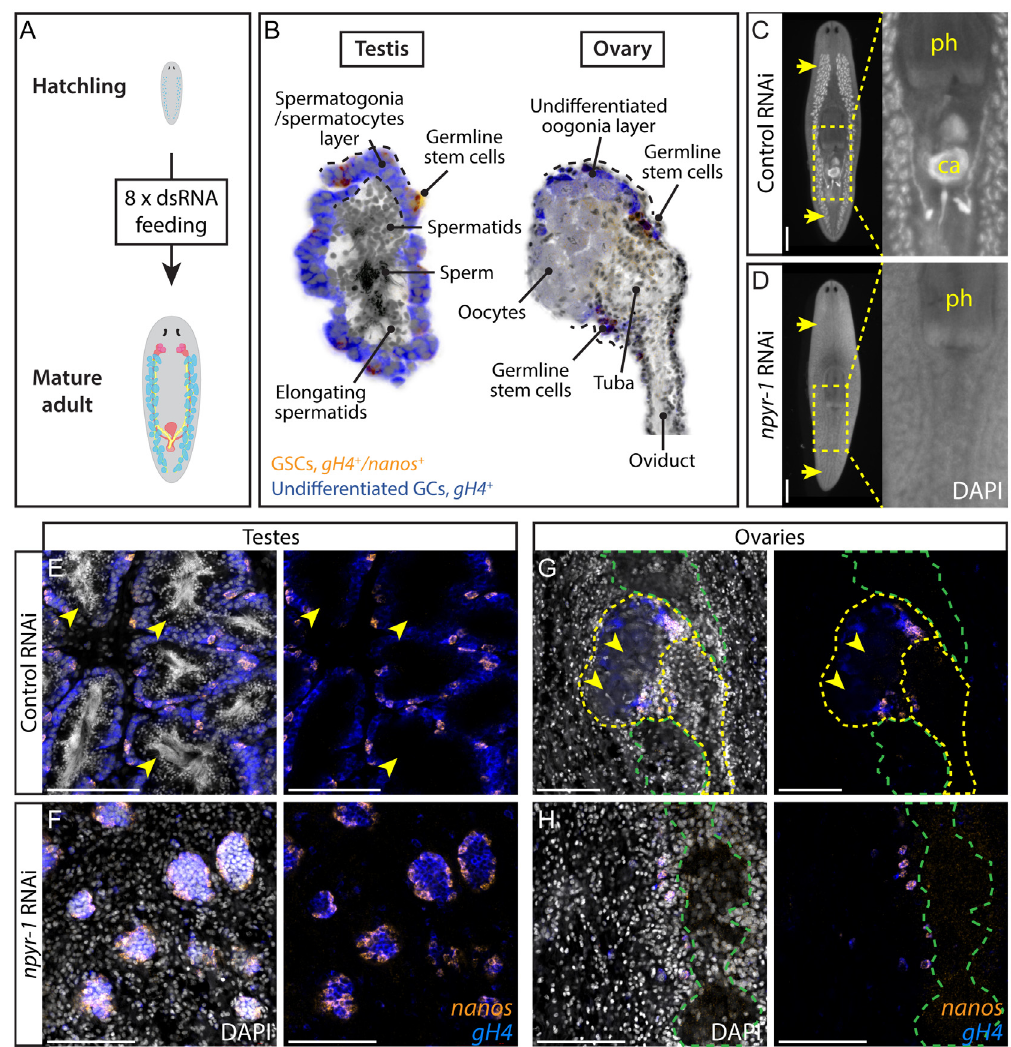
Fig 2. NPY receptor npyr-1 is required for germ cell maturation. (A) Post-embryonic development RNAi paradigm used to determine the function of genes during normal planarian growth. Hatchlings ( (cid:1) 2 wk old) were fed dsRNA corresponding to each gene eight times to ensure that control worms achieve sexual maturity. (B) Schematic showing planarian testis and ovary structures. In both testes and ovaries, nanos + /gH4 + GSCs (orange) and nanos - /gH4 + spermatogonia/oogonia (blue) are located on the periphery, while more differentiated spermatids, sperm, or oocytes (grey) are in the middle of the gonads. (C, D) DAPI staining showing testes and stored sperm in whole-mount samples. Insets show the copulatory apparatus region. Pharynx and copulatory apparatus are marked by “ ph ” and “ ca ” , respectively. RNAi treatment followed the paradigm in A. Control worms (C) develop a complete reproductive system, while npyr-1(RNAi) worms (D) lack developed reproductive tissues and mature gametes. n = 5/ 5 for each of the three npyr-1 clones and control. RNAi quantification data can be found in S4 Data. (E – H) Double- FISH labeling GSCs ( nanos + /gH4 + , orange) and spermatogonia ( nanos - /gH4 + , blue) in whole-mount control and npyr-1(RNAi) samples. GSCs and spermatogonial cells are present in both conditions. Testis germ cells differentiate into sperm and spermatids (arrowheads) in control worms (E), but not in npyr-1(RNAi) worms (F). In ovaries, mature oocytes with large cytoplasm (arrowheads) are surrounded by gH4 + oogonia in control planarians (G), but are absent in npyr-1(RNAi) animals (H). DAPI (grey) labels nuclei. Yellow dashed lines indicate ovaries and oviducts in G and H. Green dashed lines indicate cephalic ganglia near the ovaries. Scale bars are 1 mm in C and D and 100 μ m in E – H. See also S3